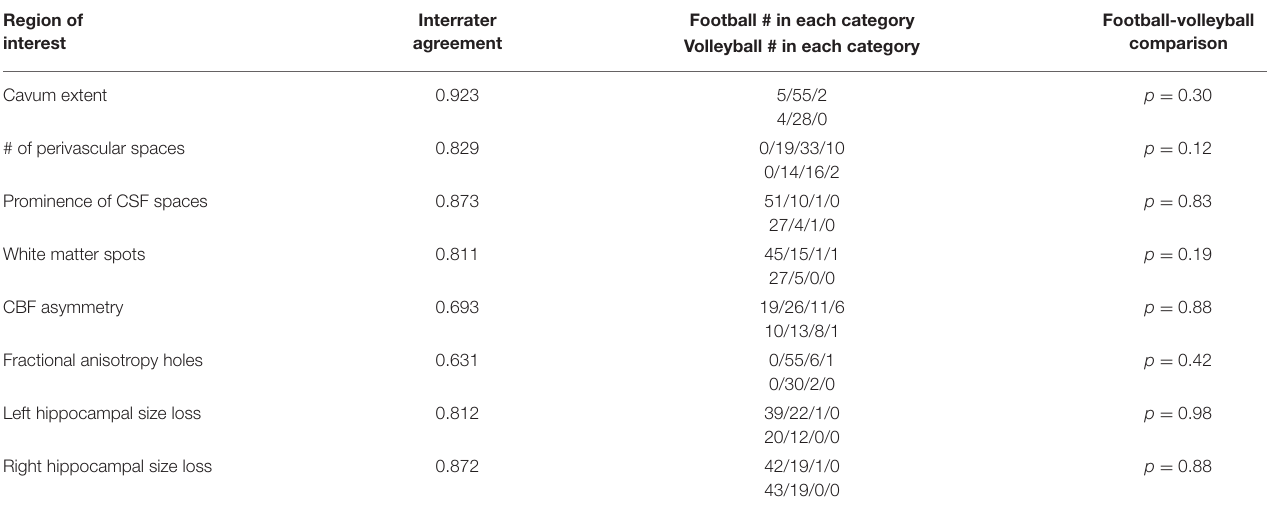
TABLE 2 | For baseline MRIs, interrater agreement and baseline comparison of football with volleyball across rater metrics by a Wilcoxon-Mann-Whitney test. Region of interest